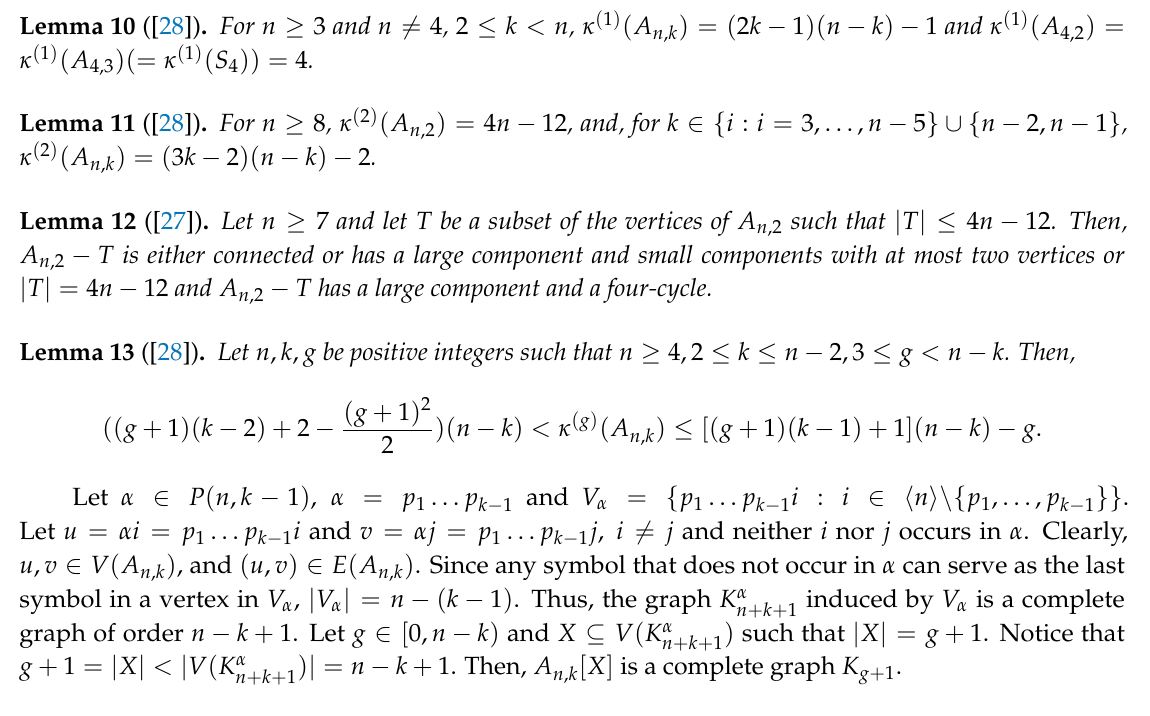
Figure 2. Illustration of a distinguishable pair ( F 1 , F 2 ) under the PMC